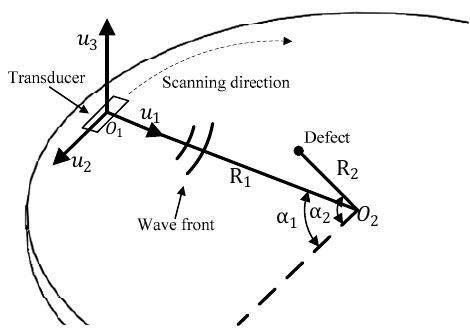
Figure 1. The diagram of the circumferential scanning using guided waves.